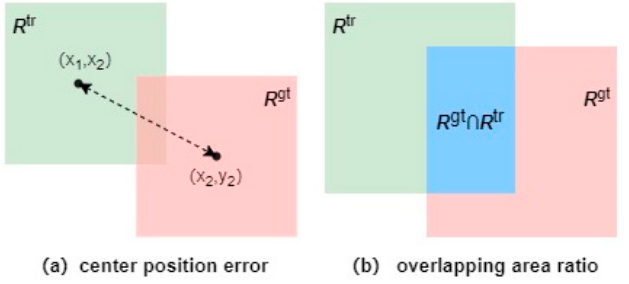
Figure 8. Visual presentation of ( a ) center position error and ( b ) overlapping area ratio. The centroid error between the target template and the search area prediction output and the overlapping area ratio of the two areas are used as the core evaluation calculation